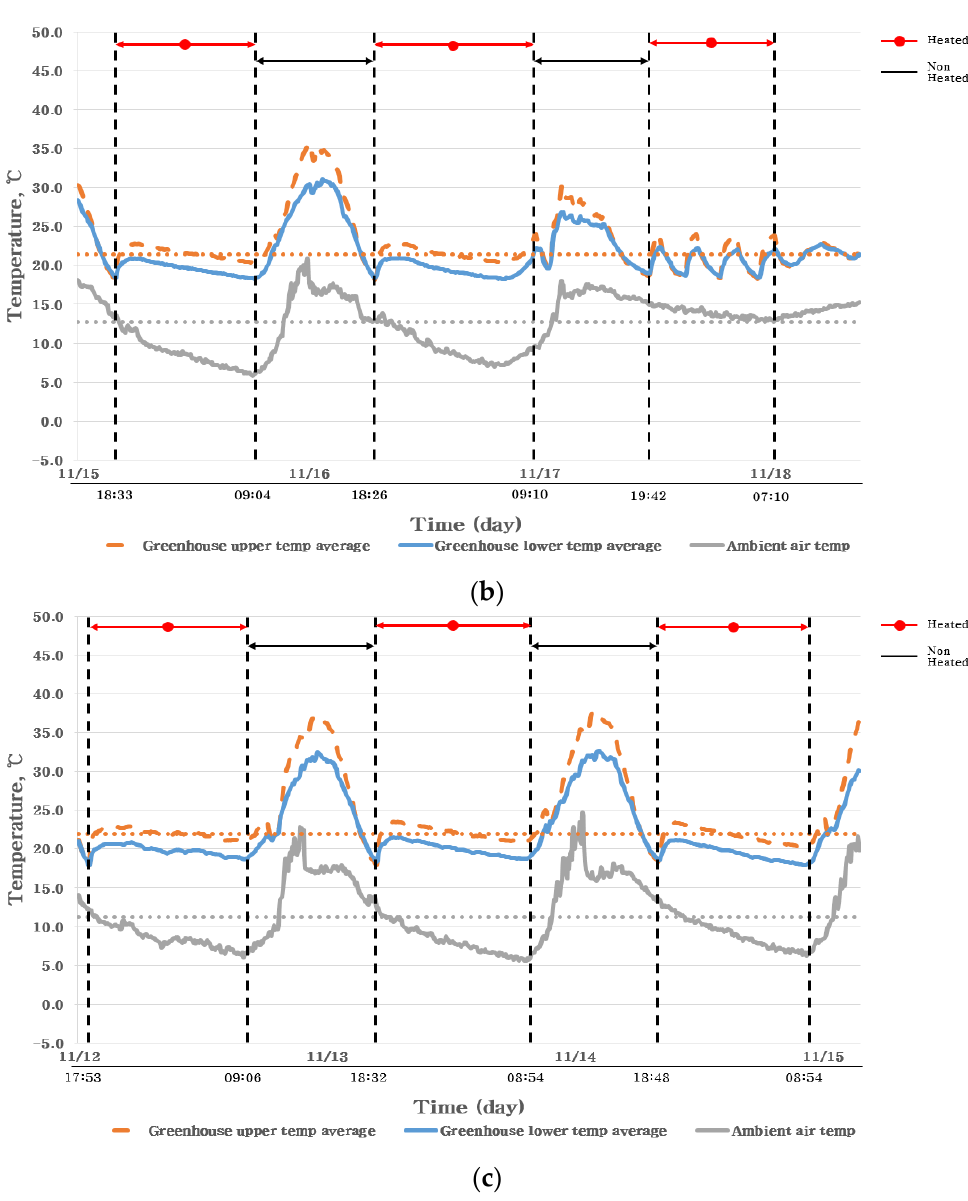
Figure 9. Experimental results showing variation of greenhouse temperature. ( a ) Hybrid system 1, ( b ) hybrid system 2, and ( c ) hybrid system 3, all at a standard temperature of 55 °C.